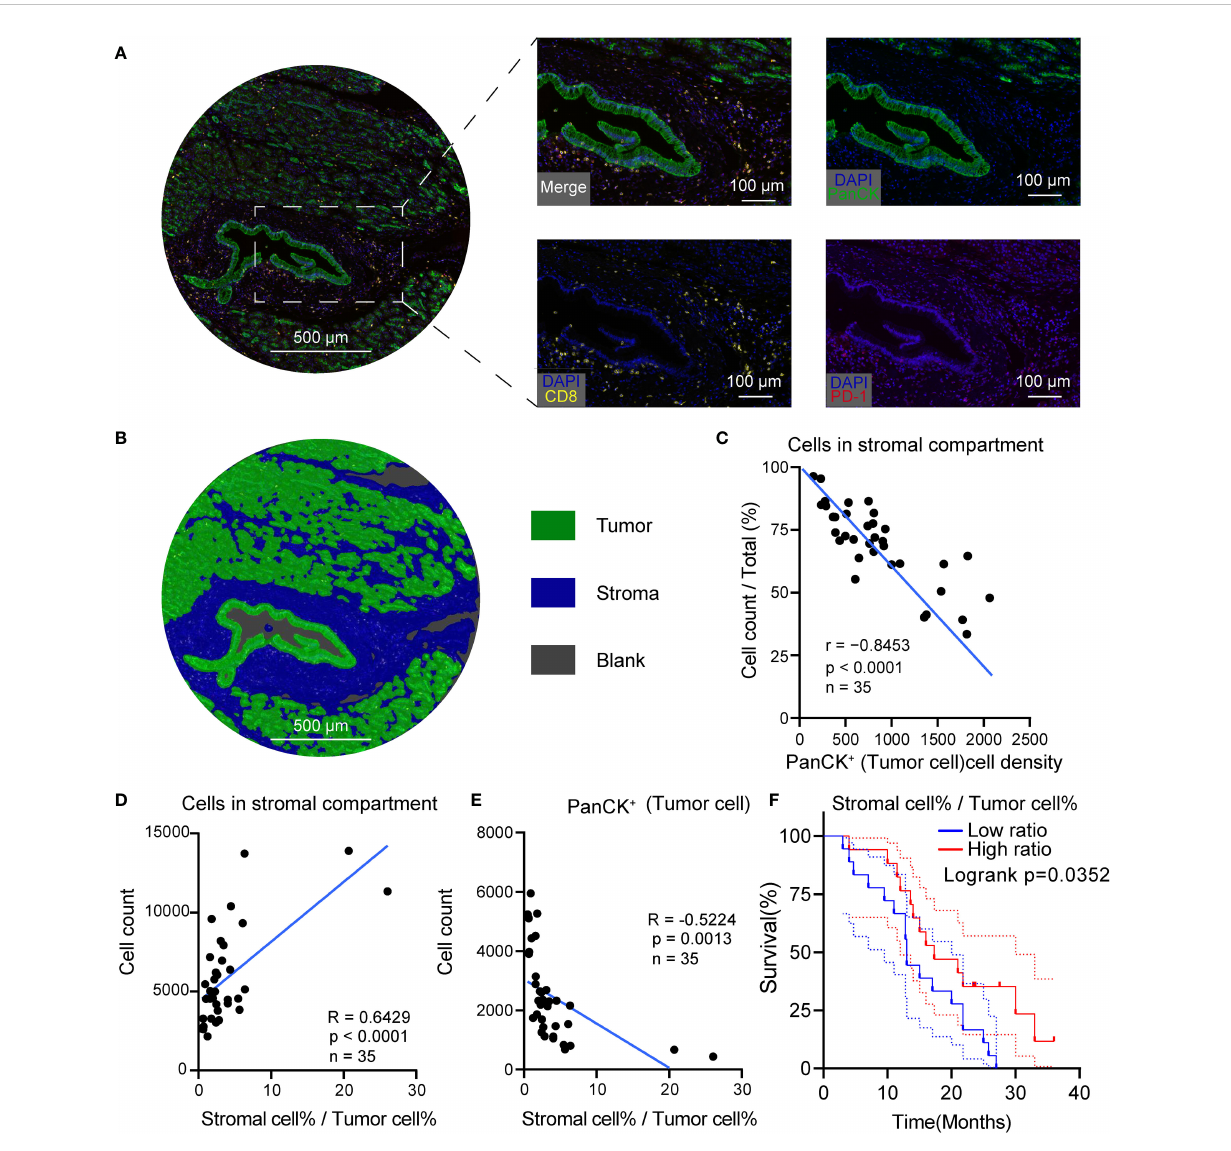
FIGURE 4 High tumor cell density was associated with low stromal cellular abundance in PDAC. (A) Representative mIHC images of PDAC. (B) Segmentation of the tumor tissue into tumor (green), stromal compartment (blue) and blank region (grey), Scale bar: 500 m m. (C) Correlation scatterplots of PanCK + cell density and stromal cell %. PanCK + cell density is the ratio of PanCK + cell count and area of classi fi ed region. Stromal cell% is the ratio of count of cells in stromal compartment and total cell count. (D) Correlation scatterplots of stromal cell count and stromal cell%/tumor cell% Tumor cell %. Tumor cell % is the ratio of PanCK + cell count and total cell count. (E) Correlation scatterplots of PanCK + cell count and stromal cell%/tumor cell% (F) Survival plot of patients in high and low stromal/tumor groups. n(high ratio) = 17, n(low ratio) =